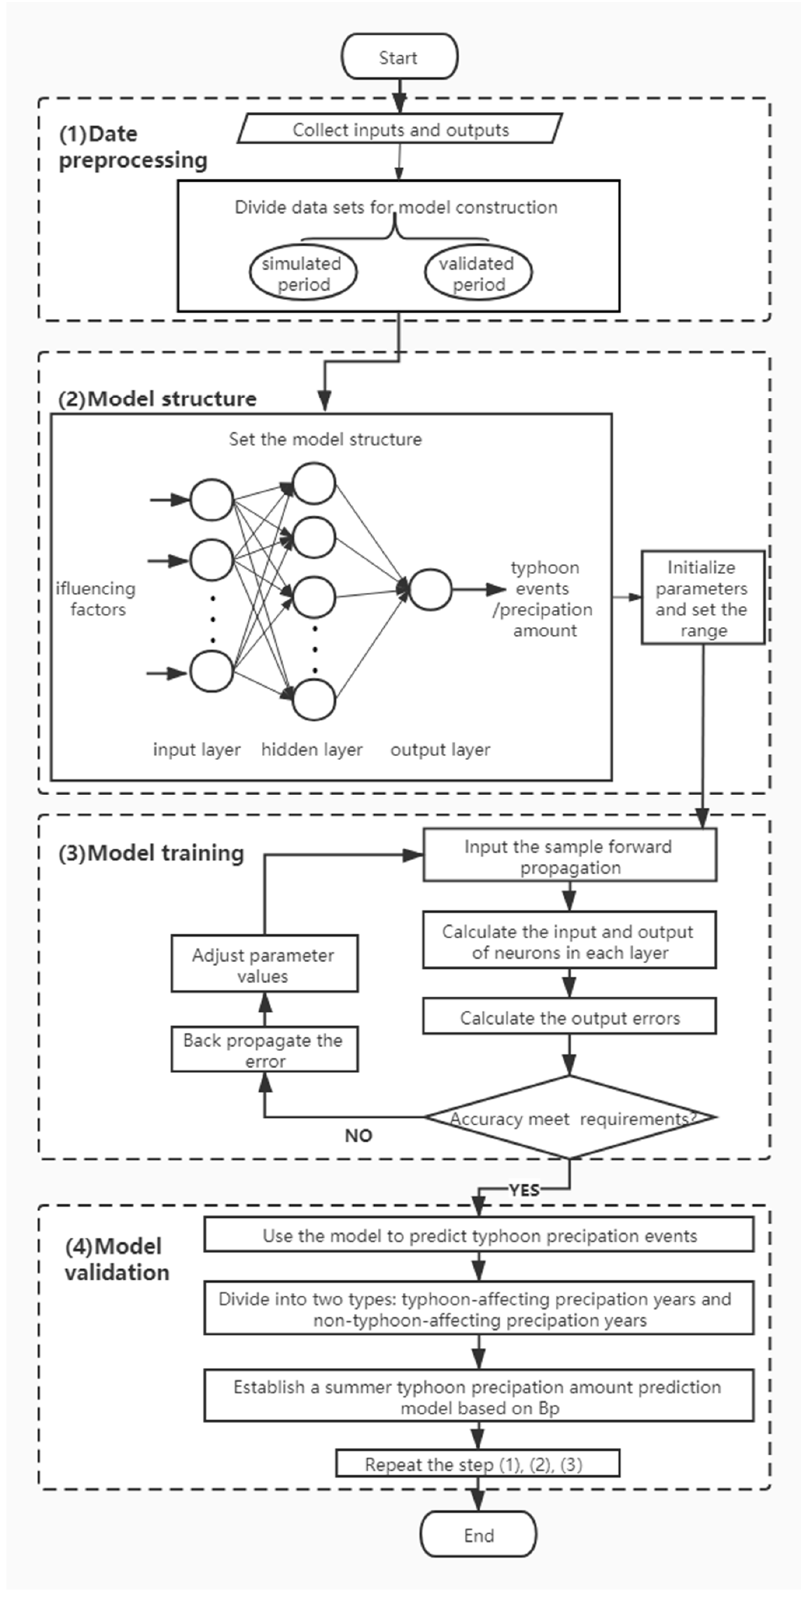
Figure 1. Structure diagram of typhoon events and typhoon precipitation amount prediction model based on back propagation (BP).